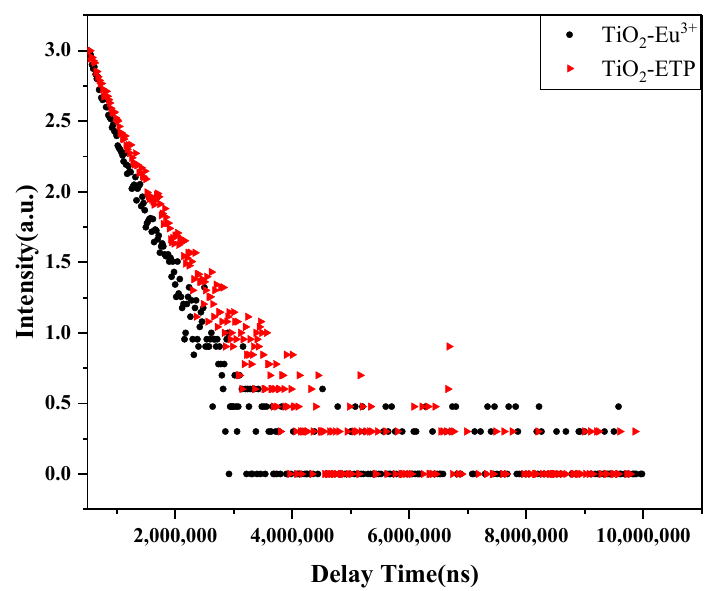
Figure 9. The fluorescence lifetime diagram of TiO 2 ‐ Eu 3+ and TiO 2 ‐ ETP.